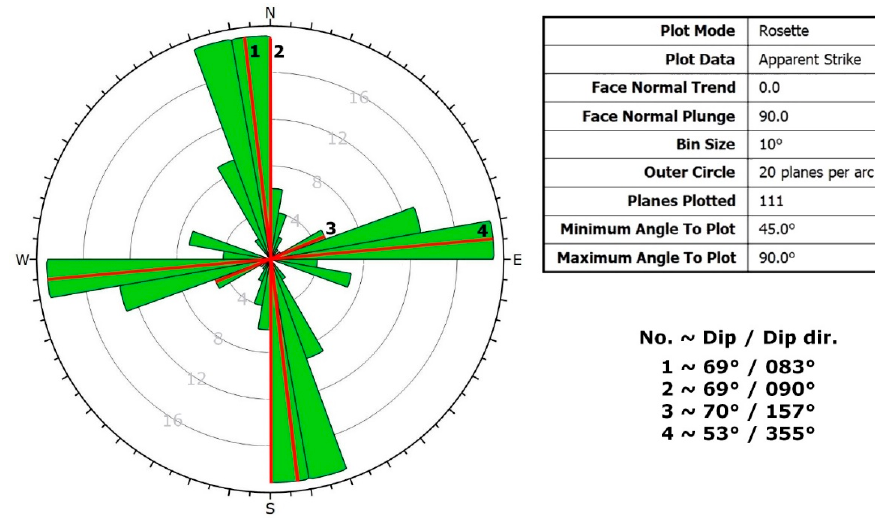
Figure 14. Rosette plot of fault planes with highlight of the four major faults (numbered by 1–4). The location of major fault planes was determined from and UAV-TLS surface model.